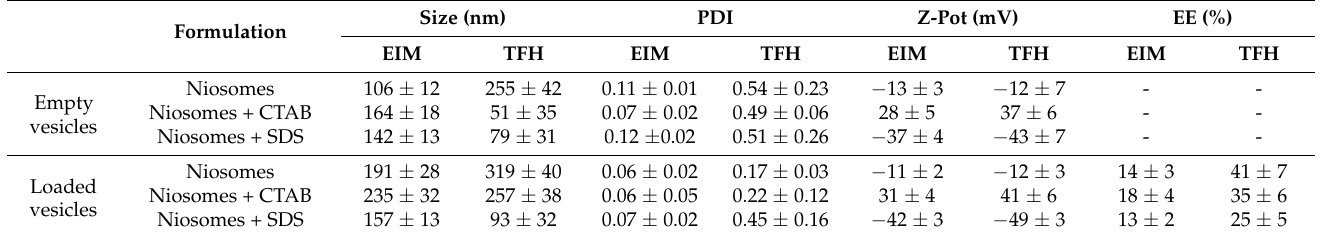
Figure 2. Particle size distribution of the three systems (niosomes, niosomes + CTAB, and niosomes + SDS) prepared by ( a , c ) ethanol injection (EIM) and ( b , d ) thin film hydration (TFH) without ( a , b ) and with ( c , d ) vanillin encapsulated. Table 2. Size, PDI, and zeta potential for the nanovesicles prepared with the three formulations by ethanol injection and thin film hydration.